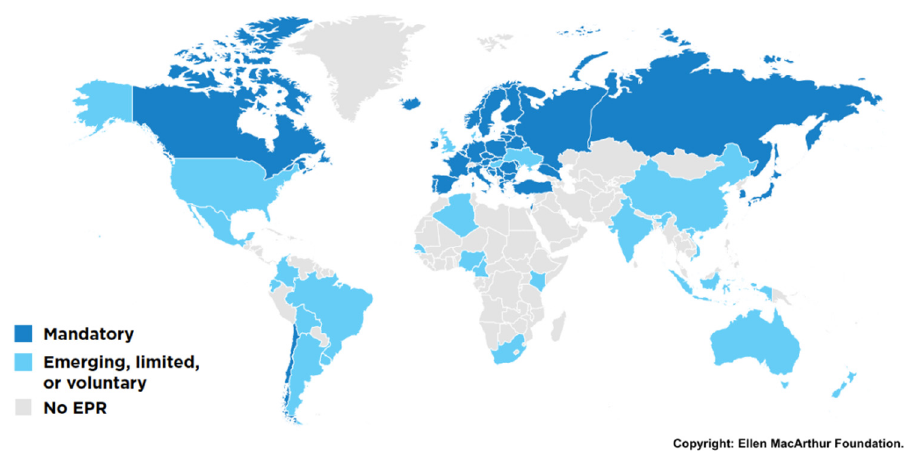
Figure 1. Overview of packaging EPR schemes implementation around the globe in 2020 [130].